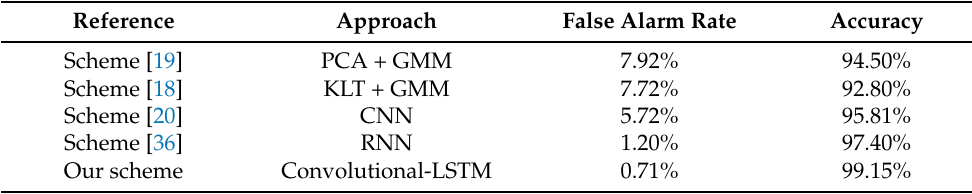
Table 5. Detection performance in different